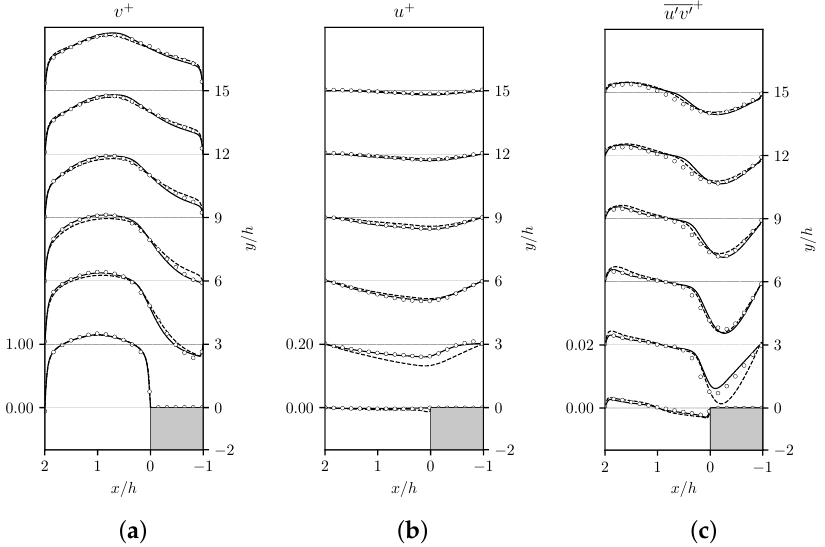
: DNS data. ◦ + = u v U 2 is reported (cid:48) (cid:48) / b